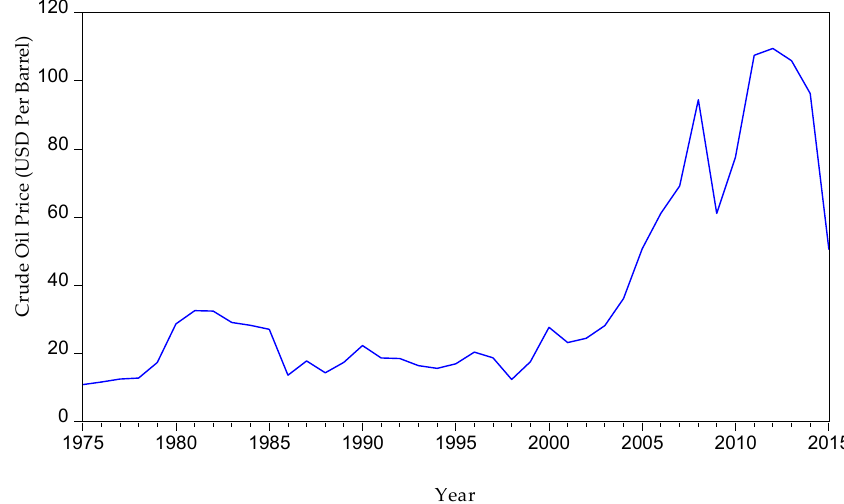
Figure 1. Crude oil price movements. Source: This graph was plotted by the first author based on the data reported in the OPEC Annual Statistical Report [8] using the software Econometric Views version 9 (Information Handling Services (IHS) Market Ltd., London, United Kingdom).